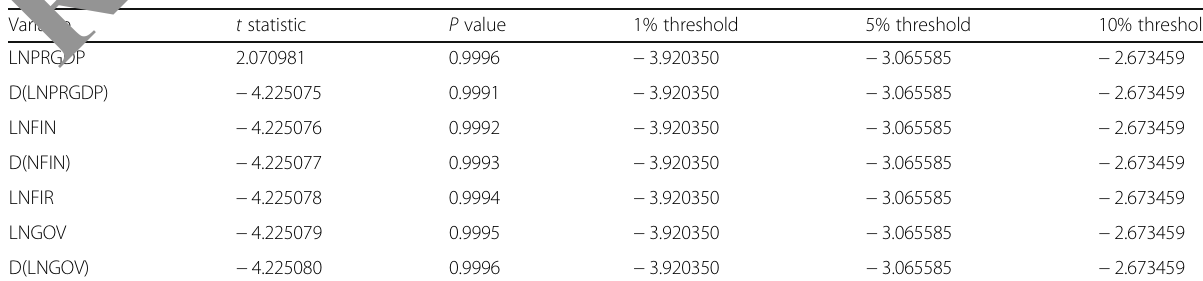
Table 2 Unit test